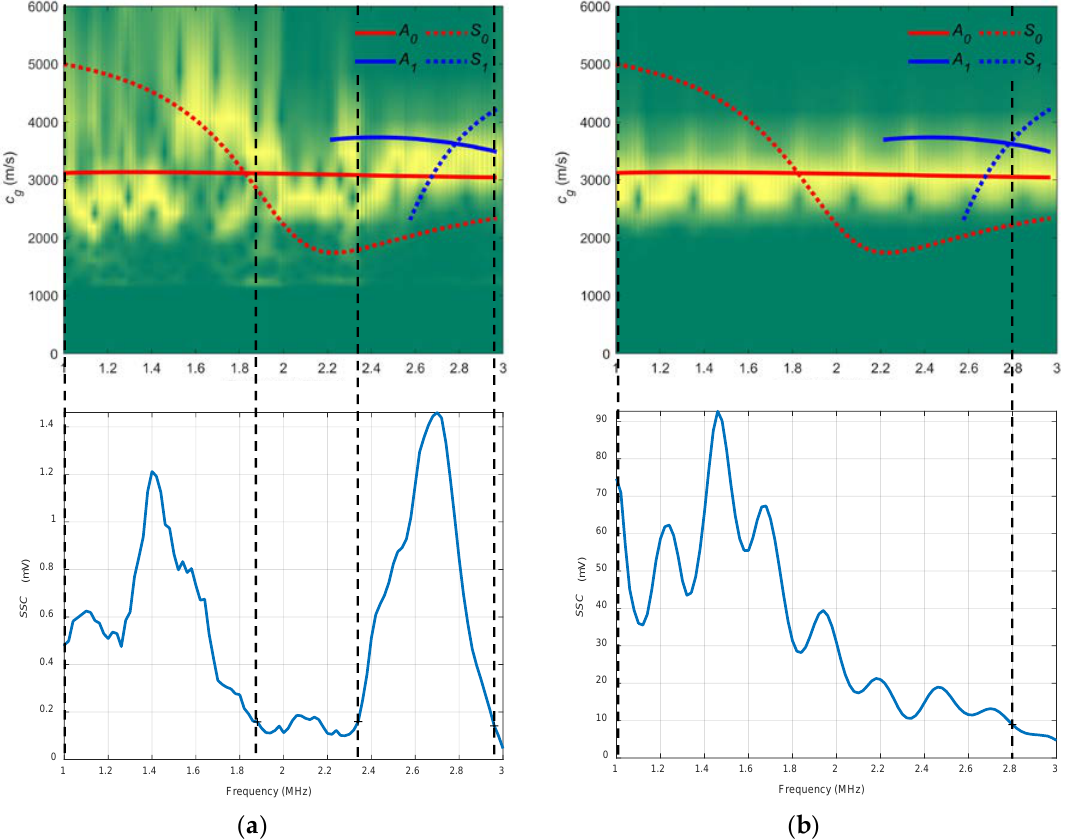
Figure 10. Combined spectrograms and sensitivity system curves ( SSC ) from the immersion setup to measure the stainless-steel plate: ( a ) 20°; ( b ) 40°.